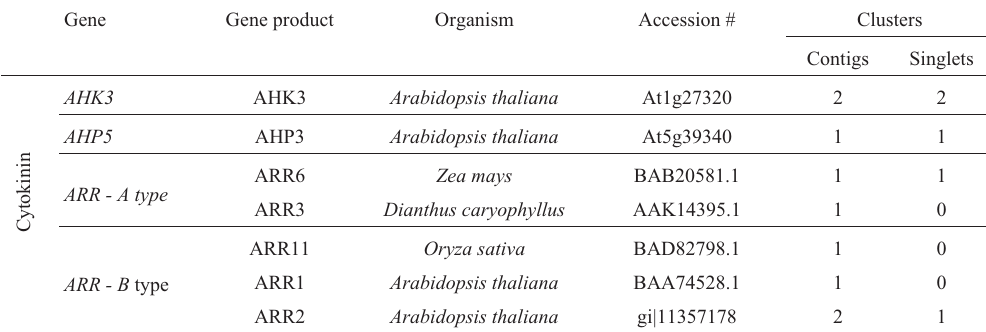
Table 2 - Ortholog genes of Cytokinin signaling pathways found in the Citrus EST database. Gene Gene